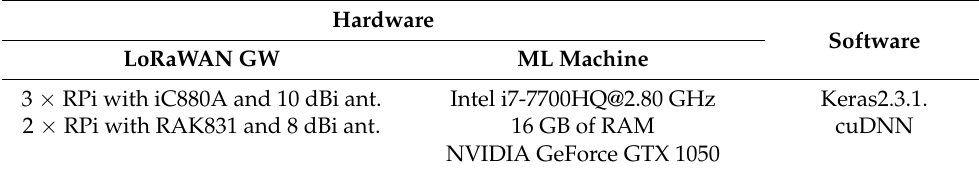
Table 1. List of used hardware and